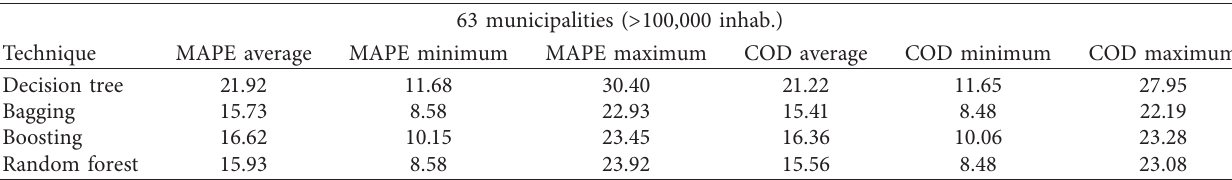
Table 3: Average, minimum, and maximum results for MAPE and COD values obtained for the 63 municipalities with more than 100,000 inhabitants. 63 municipalities ( > 100,000